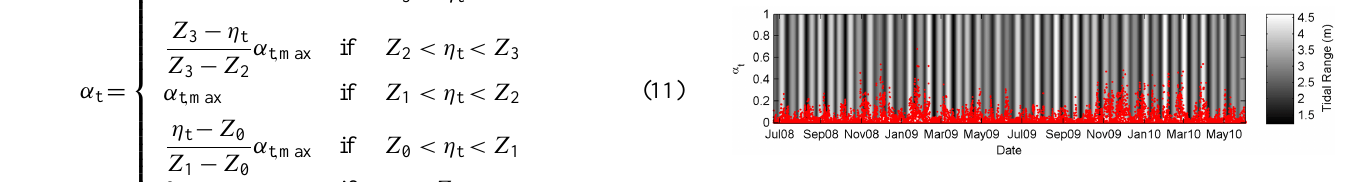
Figure 13. Time series of: the tidal correction factor α t (red dots); and the tidal range (greyscale, vertical